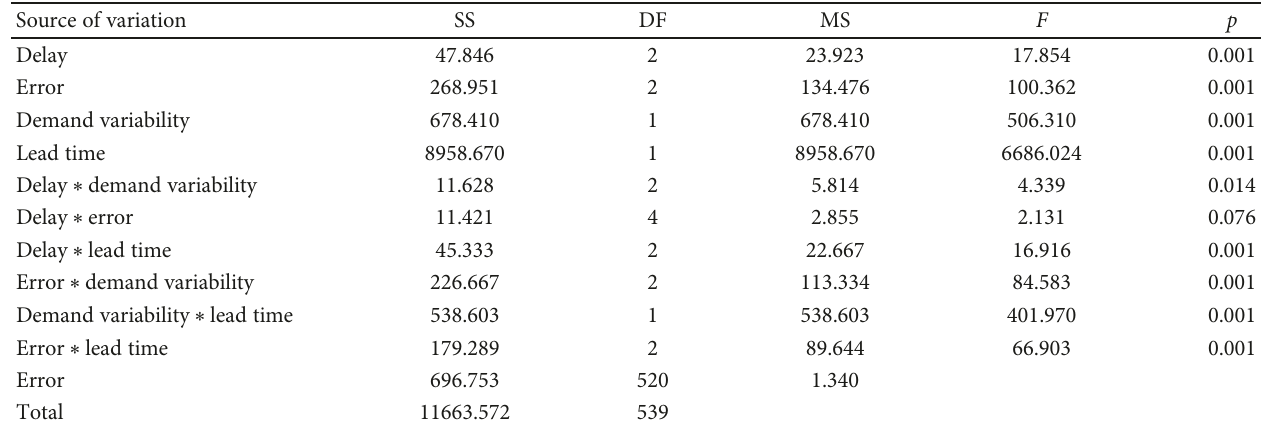
Table 8: ANOVA results for the inventory variance